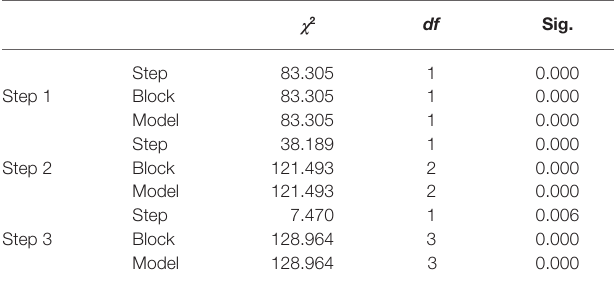
TABLE 2 | Omnibus tests on the sociodemographic model coefficients.